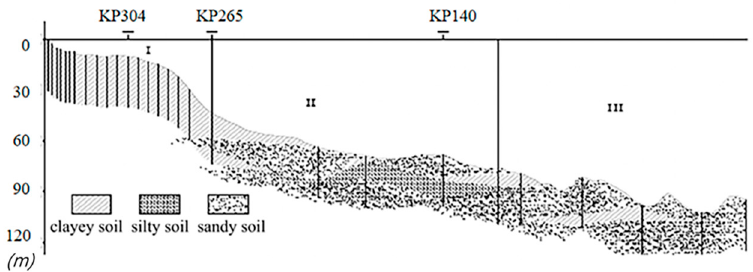
Figure 4. Zonation map of submarine pipeline routing area.